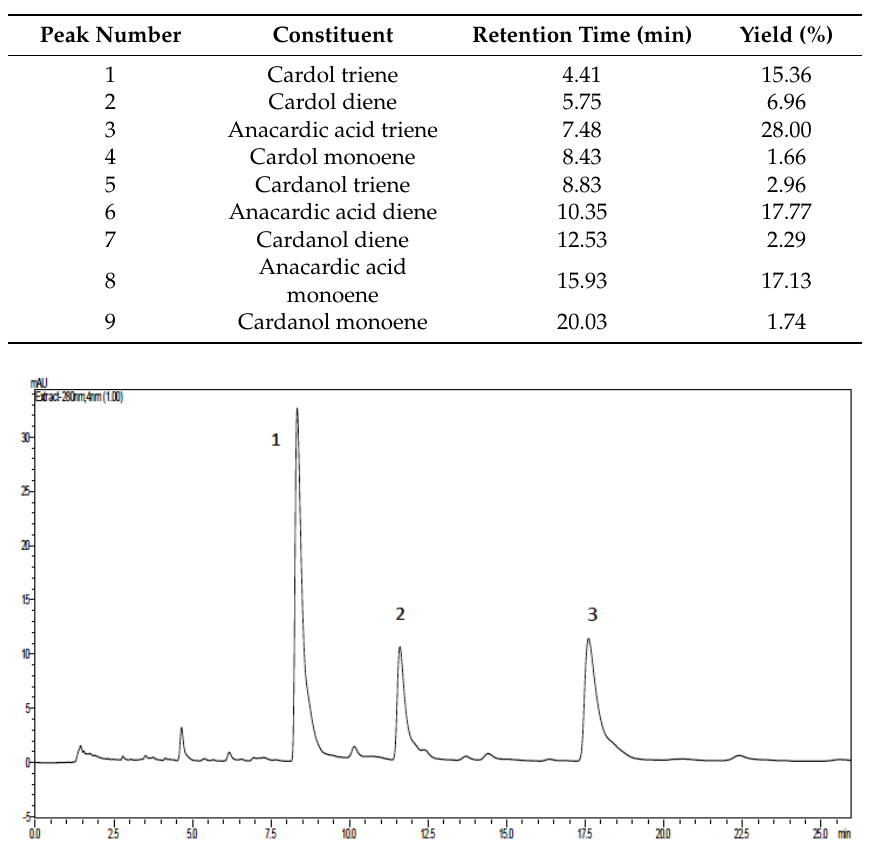
Figure 2. Representative high performance liquid chromatography (HPLC) profile of anacardic acids obtained from cashew nut shell liquid (CNSL).